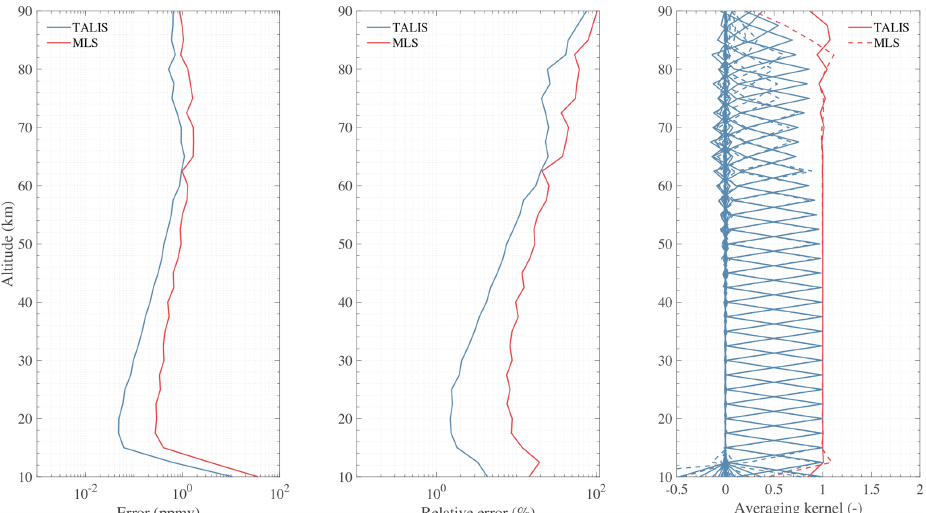
Figure 10. H 2 O product comparison between the TALIS FFT spectrometer and MLS “Standard” spectrometer using the 183.31GHz line. All other factors are identical.